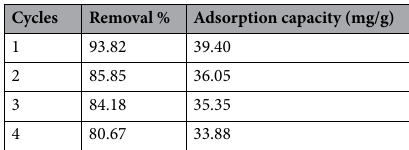
Table 4. The results of reusability of the sorbent.